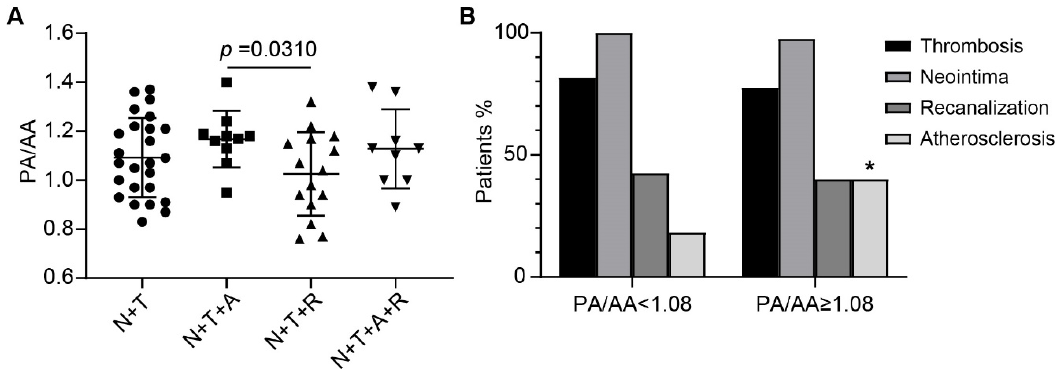
Figure 4. Association between atherosclerotic lesion formation and main pulmonary artery dilation in CTEPH. ( A ) In the presence of neointima and thrombi, the mean PA/AA is higher in cases with atherosclerotic lesions than those with recanalized neo-vessels. N, neointima, T, thrombus, A, atherosclerosis, R, recanalization. ( B ), Patients with PA/AA ≥ 1.08 were more frequently identified with atherosclerotic lesions. Data are presented as the mean ± SD. * p < 0.05. Student’s t -test for ( A ) and chi-square test for ( B